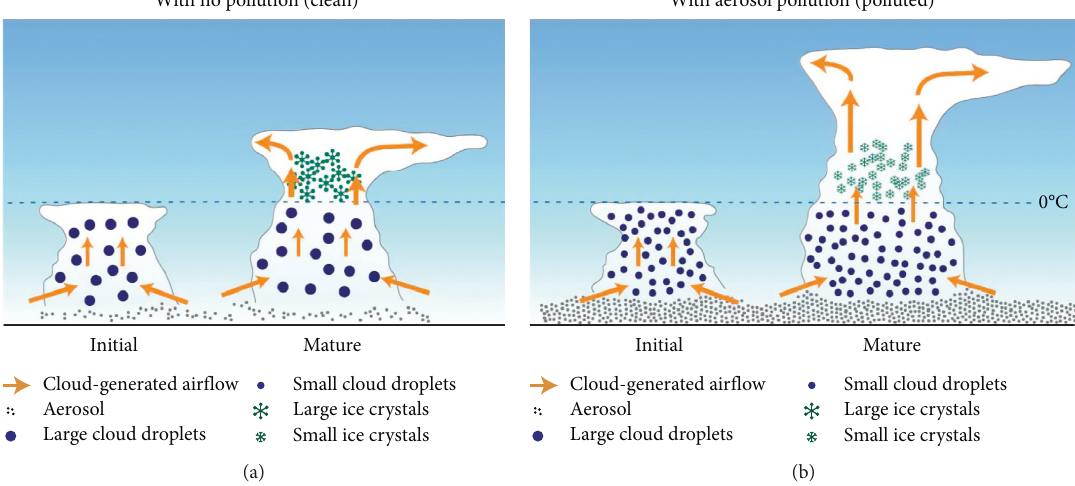
Figure 1: (a) Airflow generated by convective clouds carries water droplets upwards, leading to the formation of ice crystals in the upper cloud layers. (b) Aerosol pollution (or perturbation) leads to formation of more ice crystals and latent-heat release upon ice crystal formation, which stimulates the updrafts and the vertical growth of clouds (adapted from Lee